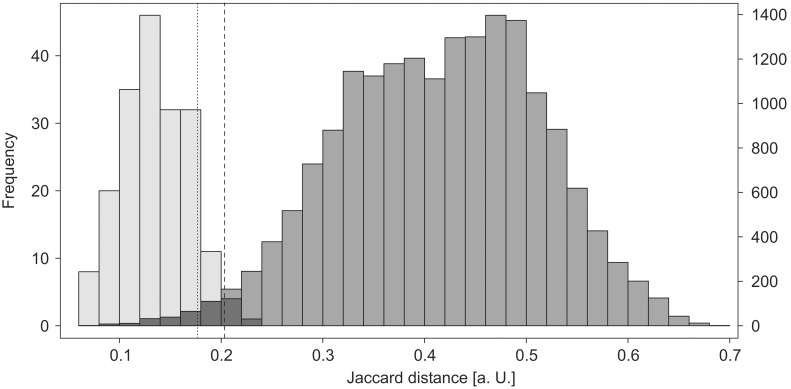
Whole spectrum similarity among non outbreak study isolates.Distribution of Jaccard distance values from pairwise spectrum comparisons among non outbreak study isolates (dark grey, n = 17955) and single isolate replicate spectra (light grey, n = 189). The dashed line represents a threshold for spectral identity derived from the replicate spectrum distribution (mean+2×SD). The dotted line represents a less conservative threshold that would correctly classify 95% of all isolate pairs that were found spectrally identical upon manual spectrum comparison.